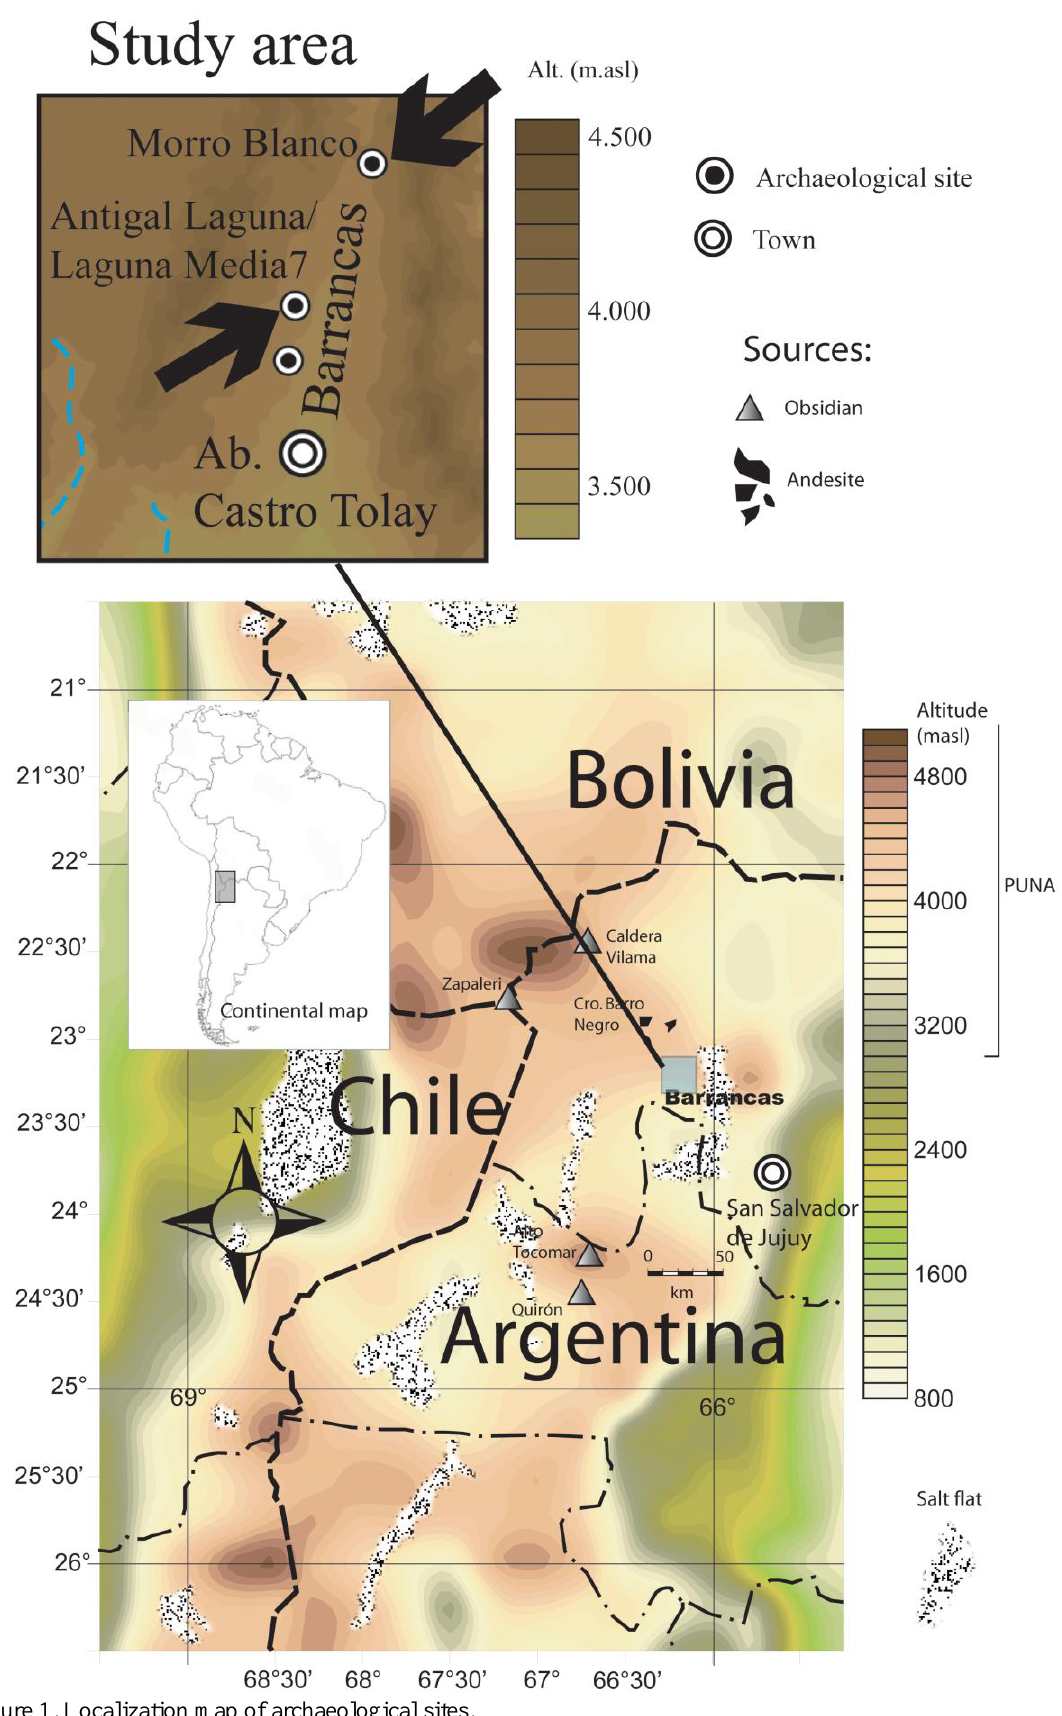
Figure 1. Localization map of archaeological